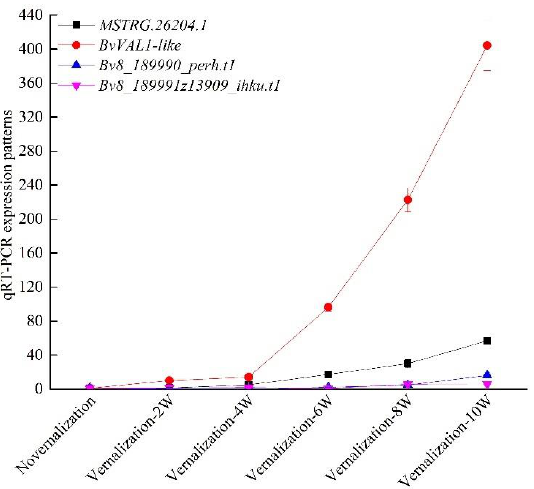
Figure 3. Co-expression network of differentially expressed long-coding RNAs and differentially expressed mRNAs. Green arrow indicate long noncoding RNA; red diamond represent mRNAs.